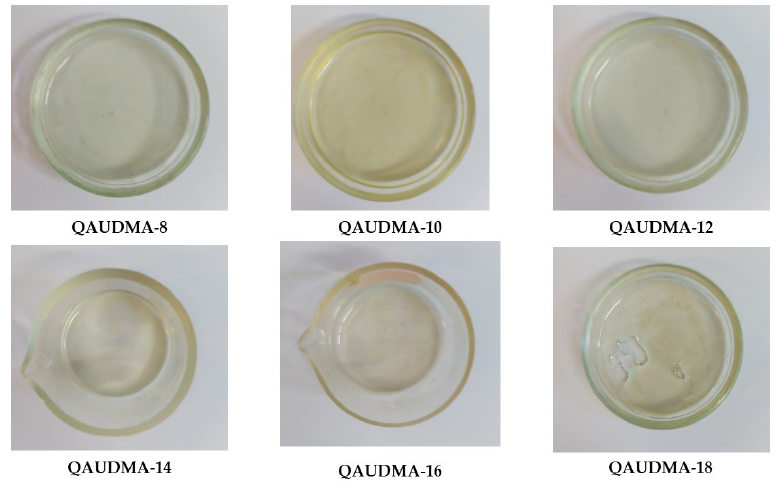
Figure 8. Photos of the obtained QAUDMAs.